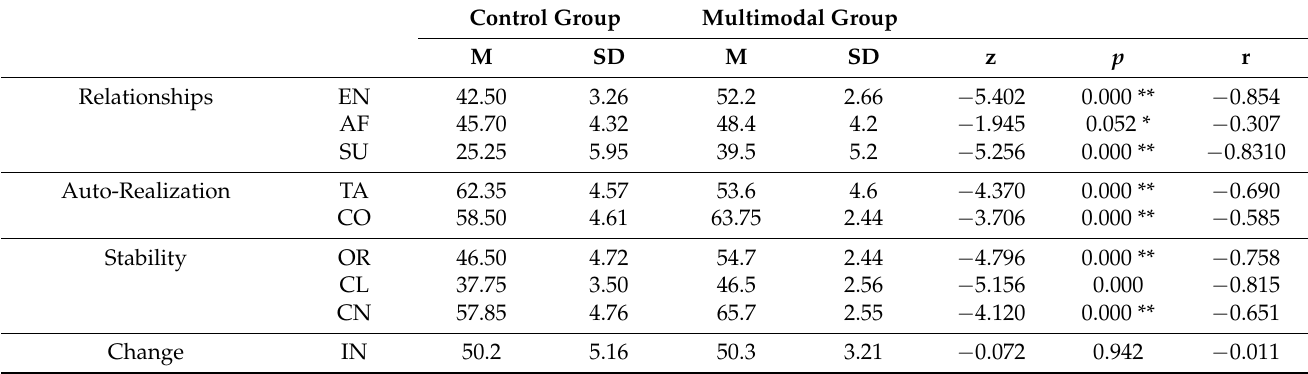
Table 7. Comparison between control and multimodal groups in the post-test. School climate. Control Group